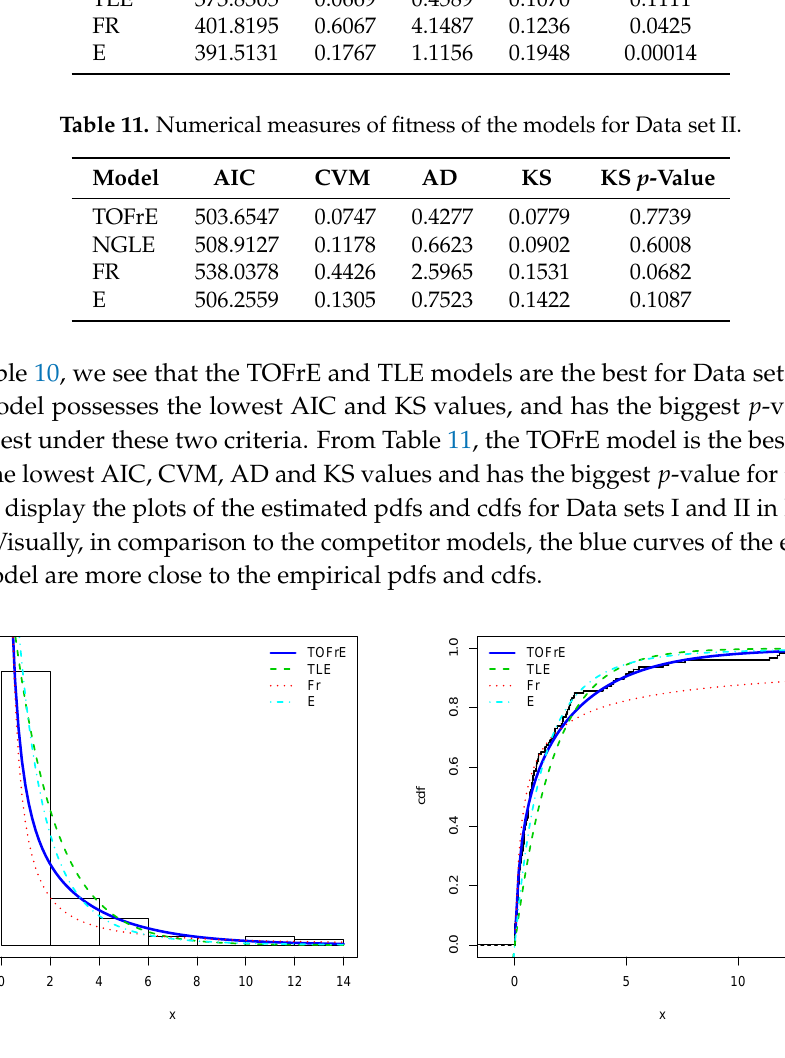
Figure 6. Plots of all the estimated pdfs and cdfs for Data set I.